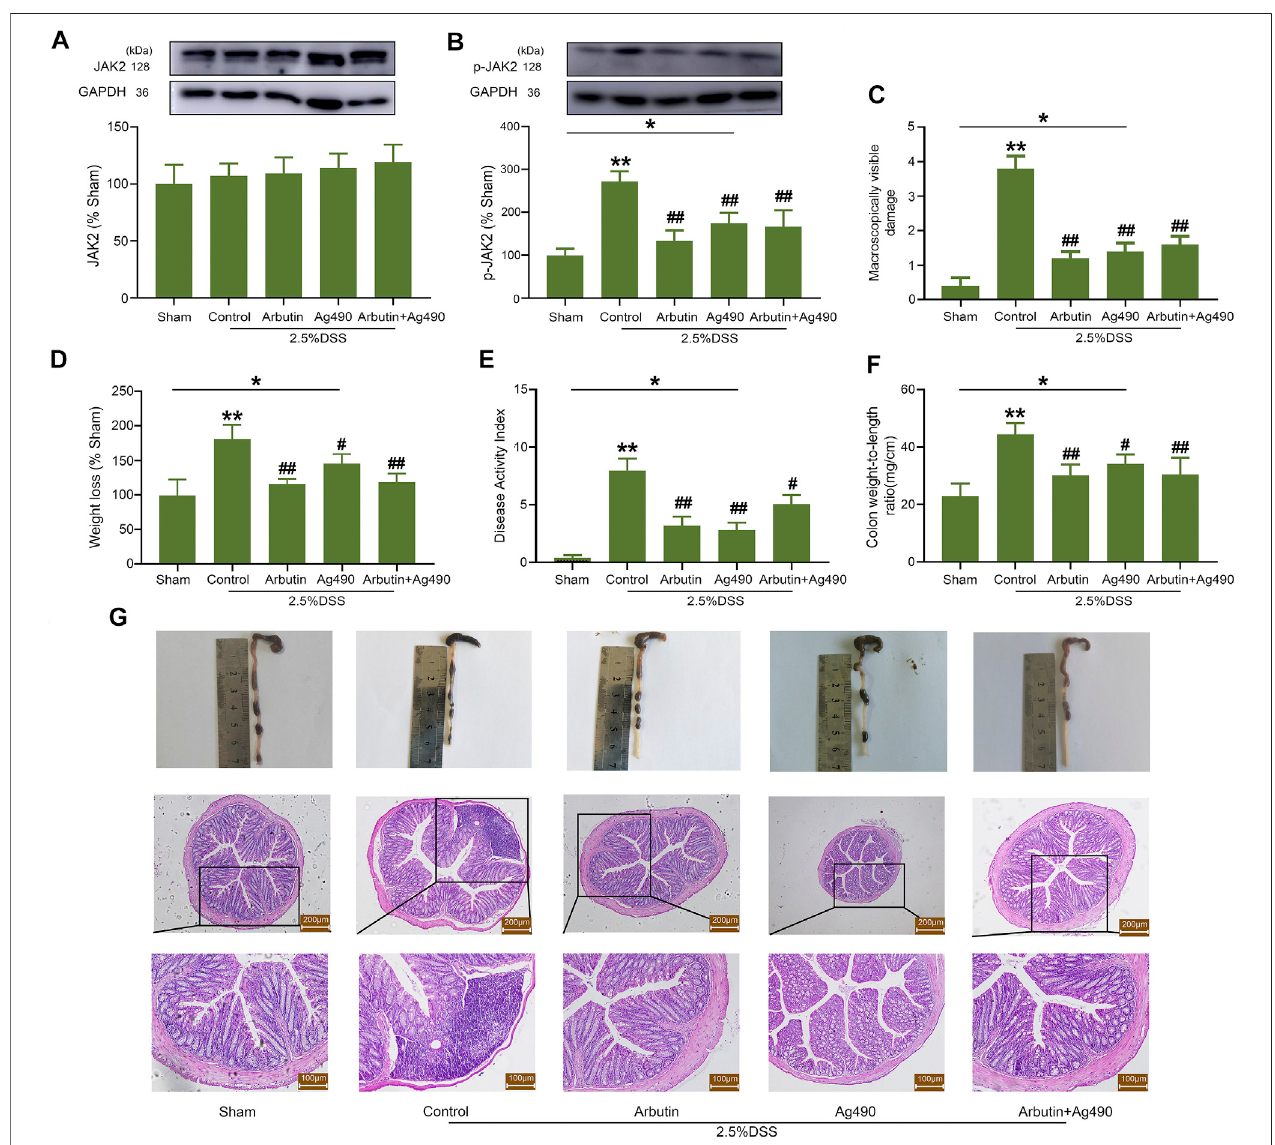
FIGURE 7 | Effects of arbutin and AG490 on UC in mice. The JAK2 protein was silenced by AG490 in mice. Under the condition that AG490 silenced the JAK2, western blot analysis of JAK2 (A) and P-JAK2 (B) , colonic macroscopically visible damage (C) , weight loss (D) , DAI (E) , colon weight-to-length ratio (F) , macroscopic observation and hematoxylin-eosin-stained colon sections (G) were recorded. Scale: upper panel is 200 μ m, lower panel is 100 μ m. Data were expressed as mean ± SD.* p < 0.05comparedbetweentheindicatedgroups;** p < 0.01comparedwithshamgroup;# p < 0.05comparedwithDSScontrolgroup;## p < 0.01compared with DSS control group; n (cid:1) 3 samples for Western blot experiments; n (cid:1) 6 samples for other experiments.